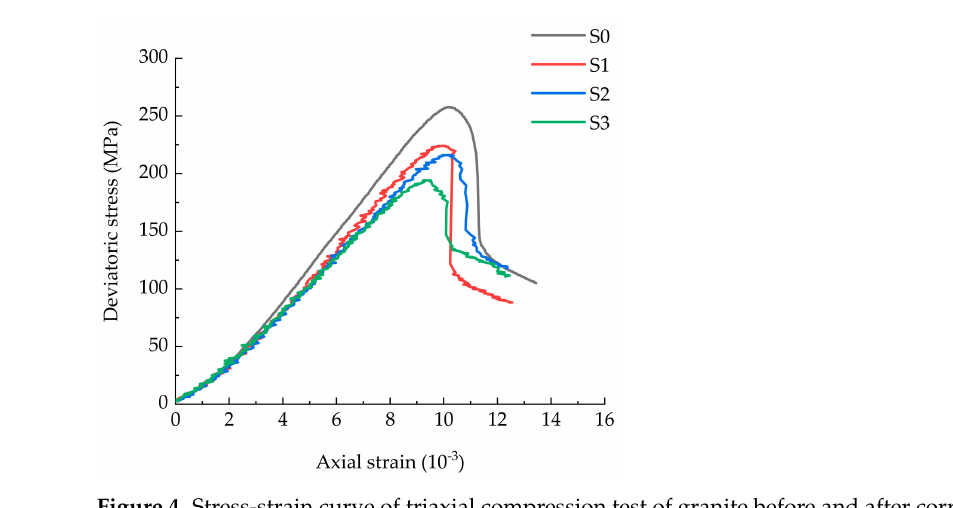
Figure 4. Stress-strain curve of triaxial compression test of granite before and after corrosion.